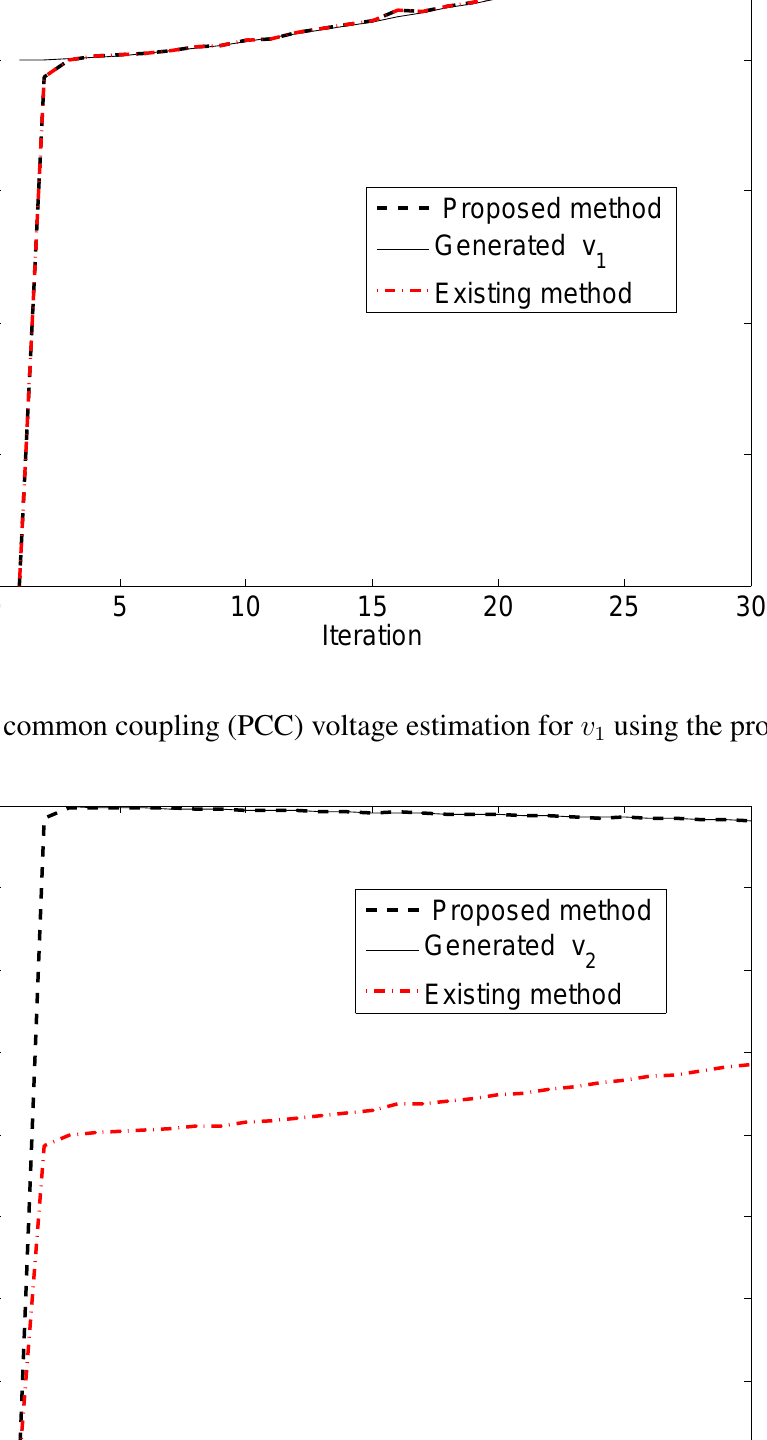
using the proposed KF 2